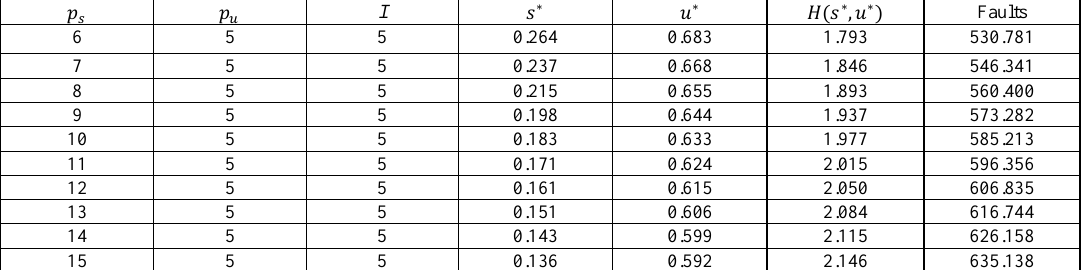
Table 7. The result of sensitivity